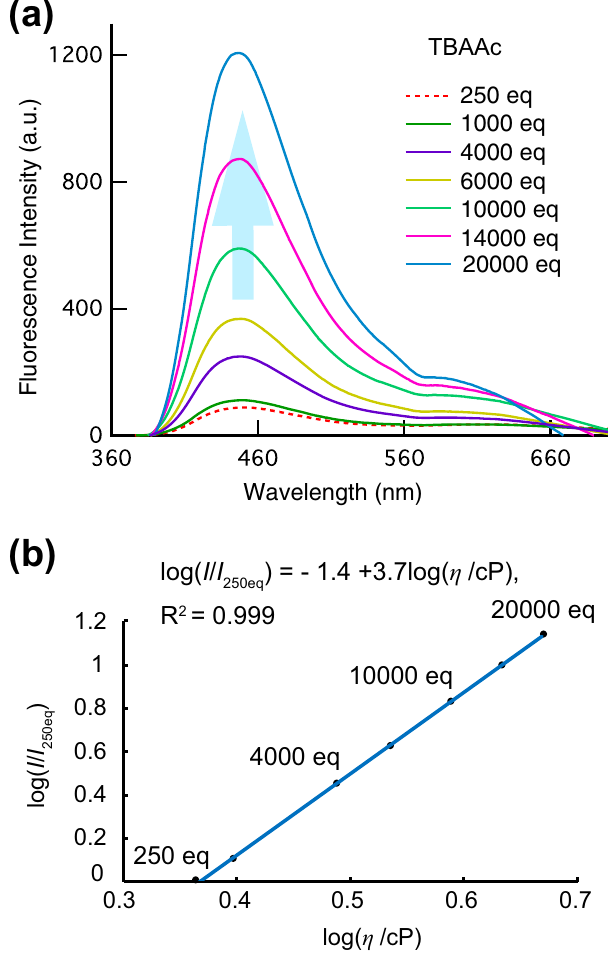
Fig. 4 Changes in fl uorescence spectra and fl uid viscosity. a Fluorescence spectra of p -2Urea (150 µ M, λ ex = 359 nm) with various excess amounts of tetrabutylammonium acetate (TBAAc) in DMSO (red dashed = 250 eq; green = 1000 eq; purple = 4000 eq; yellow = 6000 eq; yellowish green = 10,000 eq; pink = 14000 eq; blue = 20,000). b Log – log plot of the ratio of fl uorescence intensities before and after the addition of ≥ 250 equiv of TBAAc versus solvent